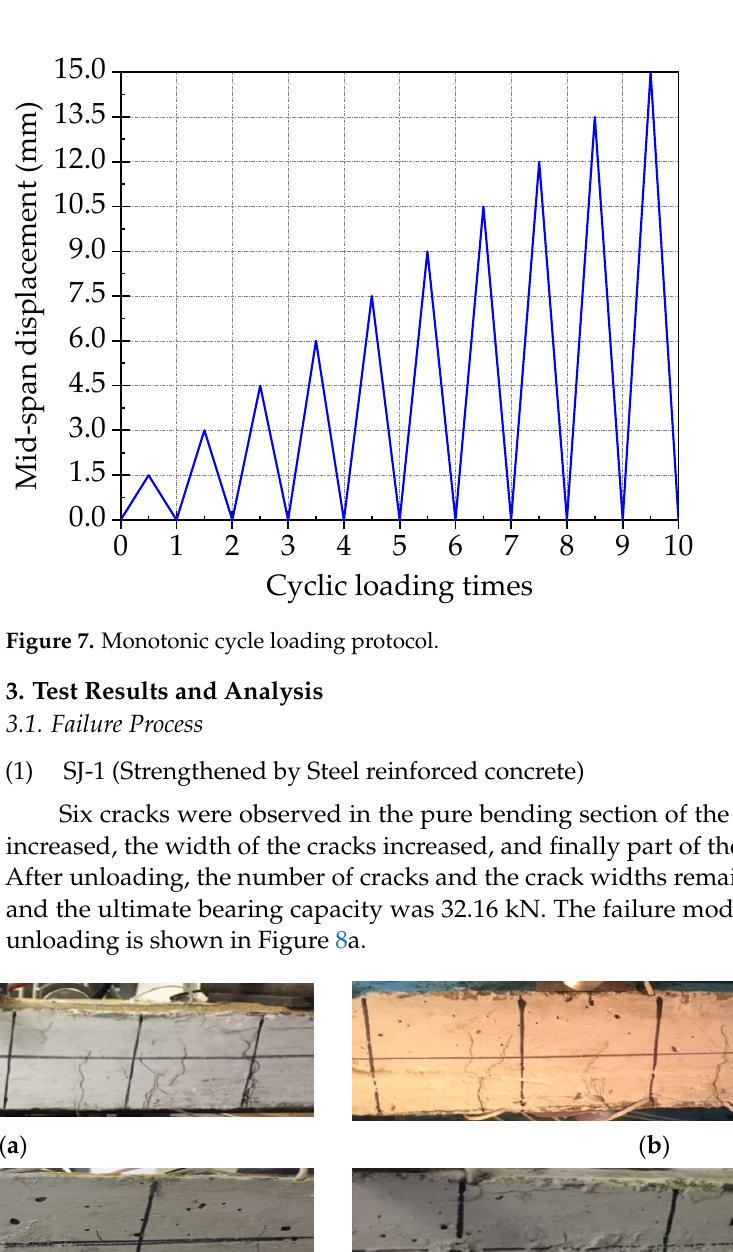
Figure 9. The crack distribution of